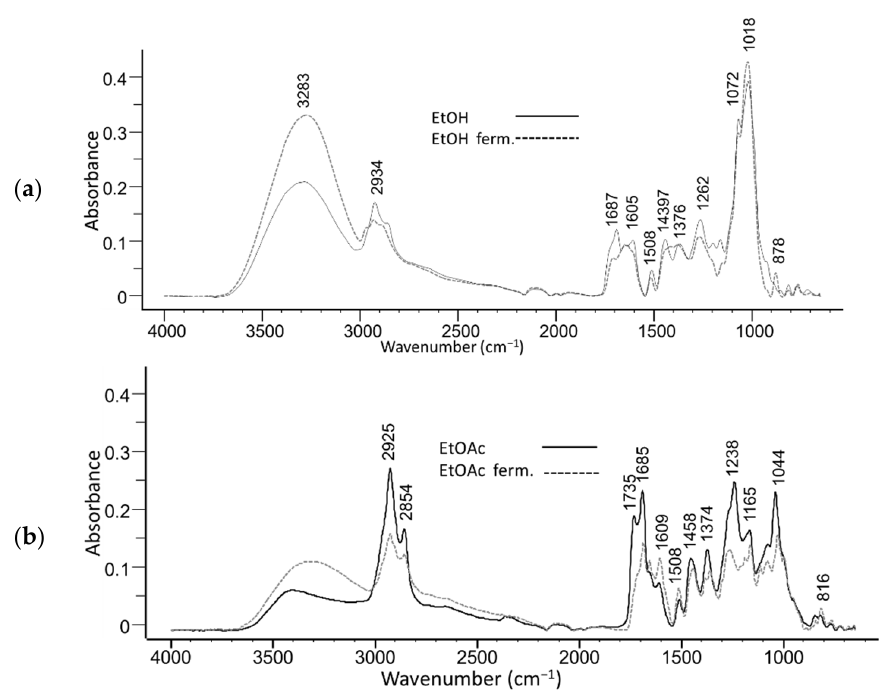
Figure 2. ATR-FTIR absorption spectra of unfermented and fermented olive leaves extracts in ( a ) ethanol, and ( b ) ethyl